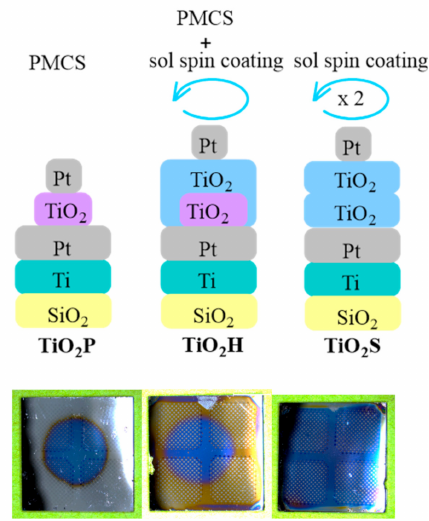
Figure 1. A schematic representation of the three memristive cells ( top ) with the TiO 2 layers produced by (from left to right) the pulsed microplasma cluster source, PMCS (TiO 2 P), the hybrid (TiO 2 H), and the sol–gel (TiO 2 S) methods, together with the images of the different type of devices ( bottom